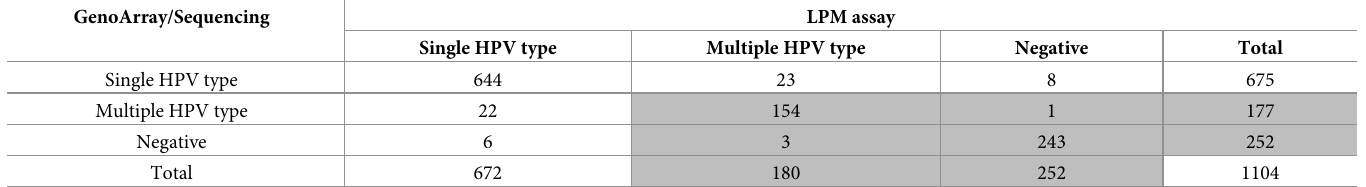
Currently, HPV GenoArray test is one of the most used methods for HPV genotyping in China. This method covers 21 HPV genotypes including 6, 11, 16, 18, 31, 33, 35, 39, 42, 43, 44, 45, 51, 52, 53, 56, 58, 59, 66, 68 and 81. Numerous studies have proven its reproducibility and clinical sensitivity. Therefore, we used it as reference for the LPM assay in this study [8, 22]. However, we found the drawbacks of GenoArray are being prone to contamination and its time-consuming procedure [8]. In addition, it is sometimes difficult to give an unambiguous result for samples with low viral load, because the determination of results is solely based on direct visualization. Real-time PCR has long been used in Vitro pathogen detection and identification, its limita- tion is only limited number of targets can be detected in one reaction, due to the limited fluo- rescence channel provided by the real-time PCR instrument [23–26]. However, it is often desirable to detect and identify multiple types of pathogen that potentially present in a clinical sample. To addressing this problem, molecular beacons labeled with different fluorophores Table 6. The counts of negative, single and multiple HPV infections identified by GenoArray/Sequencing and LPM assay and the consistent or varied results between the two methods (shadded cells). GenoArray/Sequencing LPM